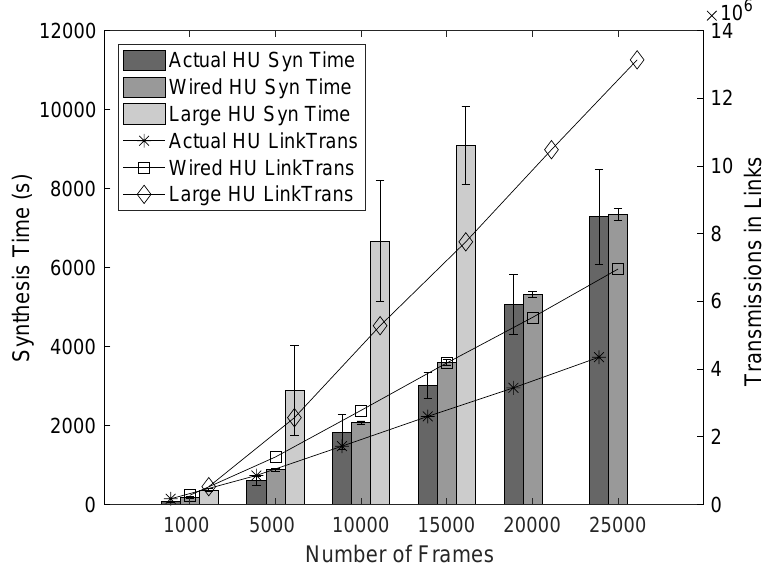
Figure 6. Synthesis time in seconds and transmissions in links for the segmented approach in different high utilization (HU)